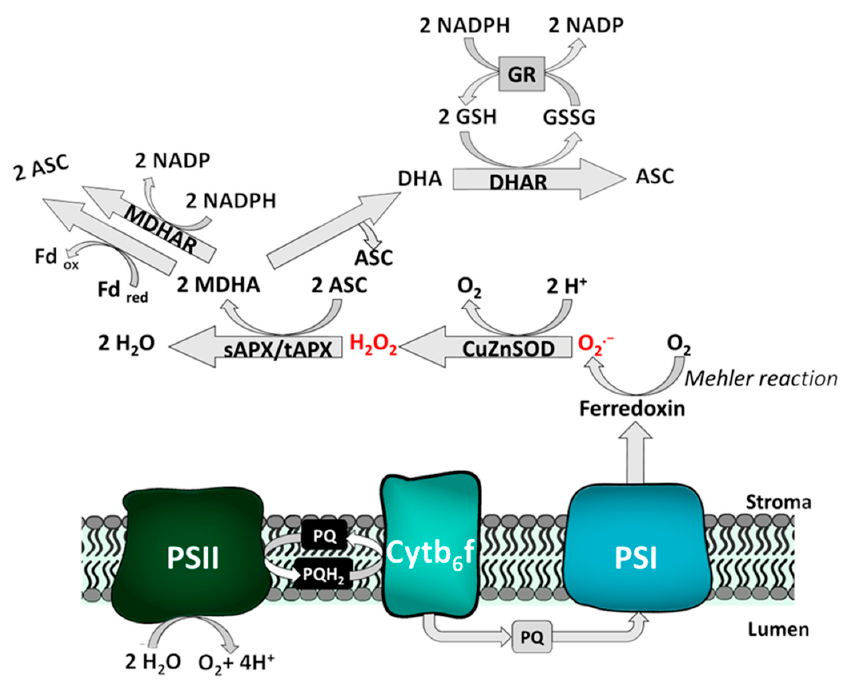
Figure 2. Generation and scavenging of ROS in the water-water-cycle. Due to over-reduction of the photosynthetic electron transport chain, super oxide radical is produced during the Mehler reaction.